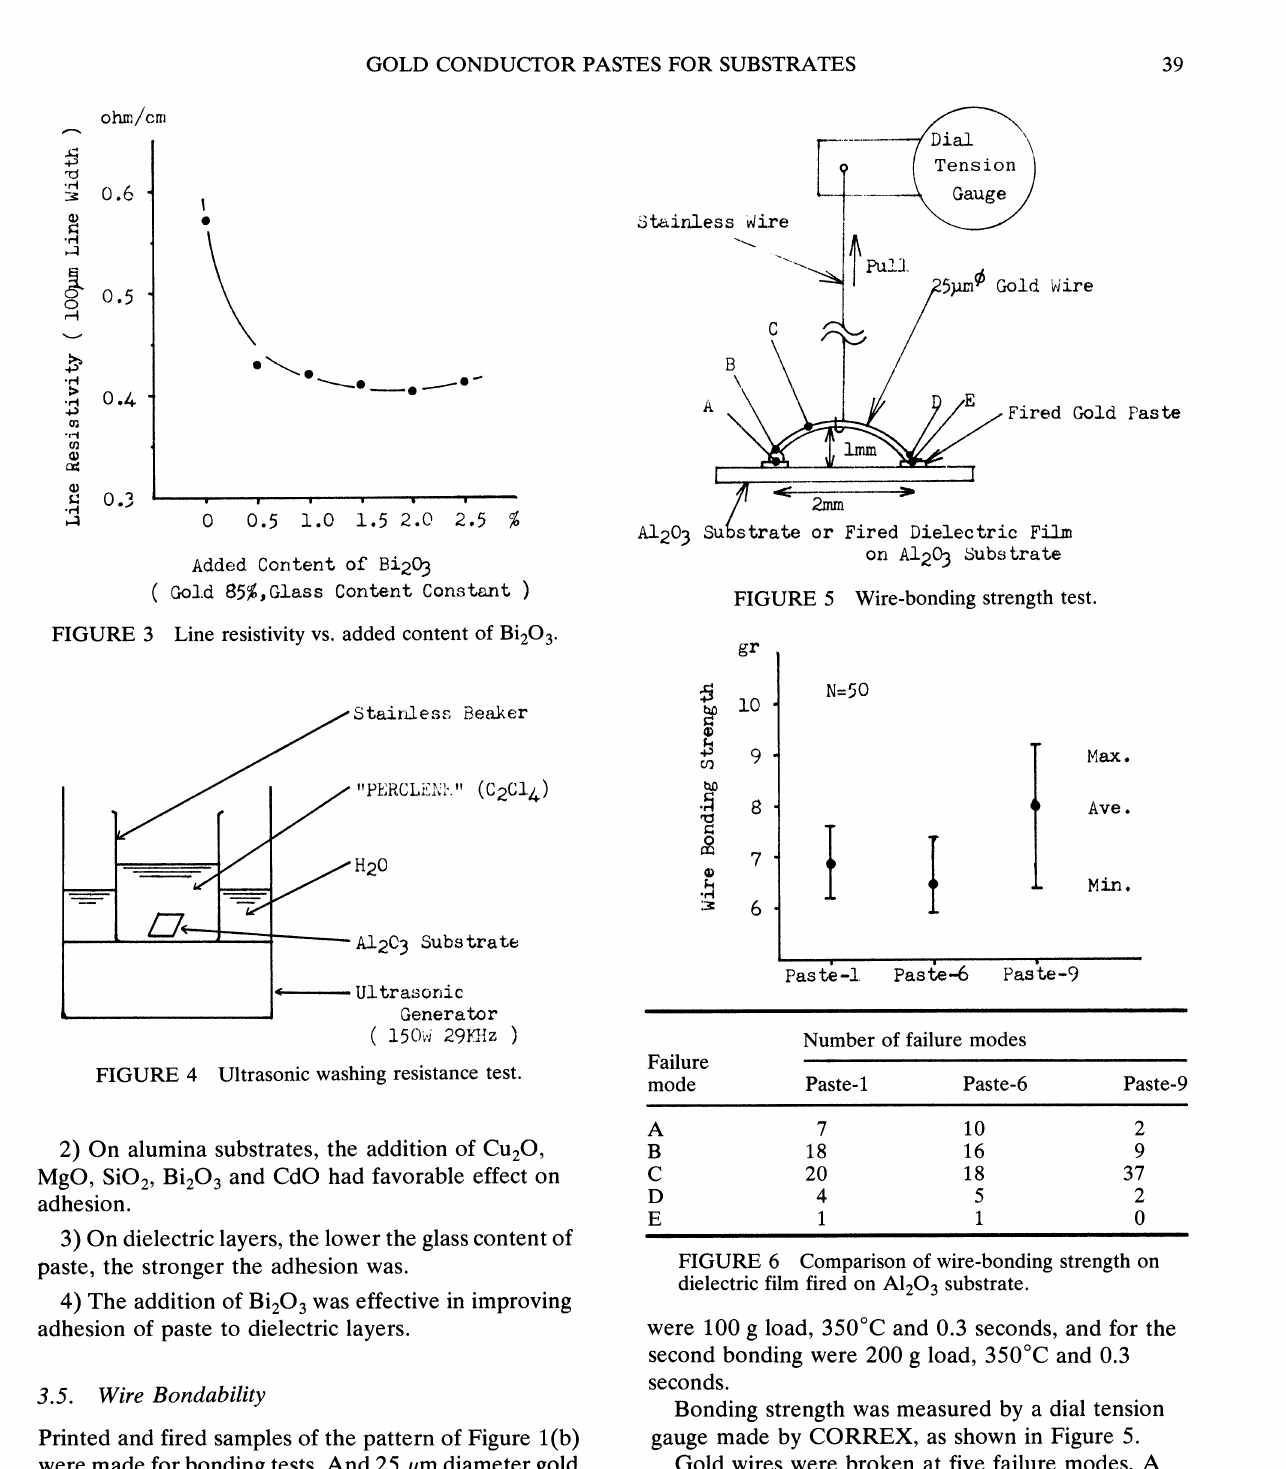
FIGURE 6 Comparison of wire-bonding strength on dielectric film fired on A1203 substrate. were 100 g load, 350C and 0.3 seconds, and for the second bonding were 200 g load, 350C and 0.3